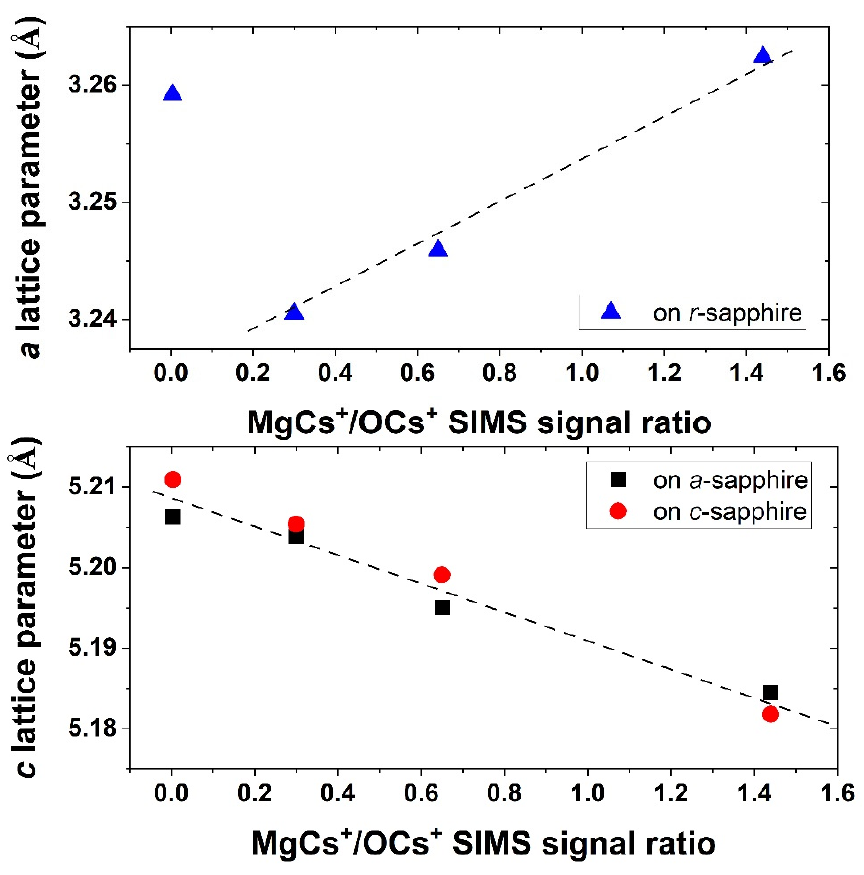
Figure 4. The a - and c -lattice parameters of Zn 1 − x Mg x O layers determined from XRD for nonpolar and polar layers, respectively, as a function of MgCs+/OCs+ SIMS signal ratio.